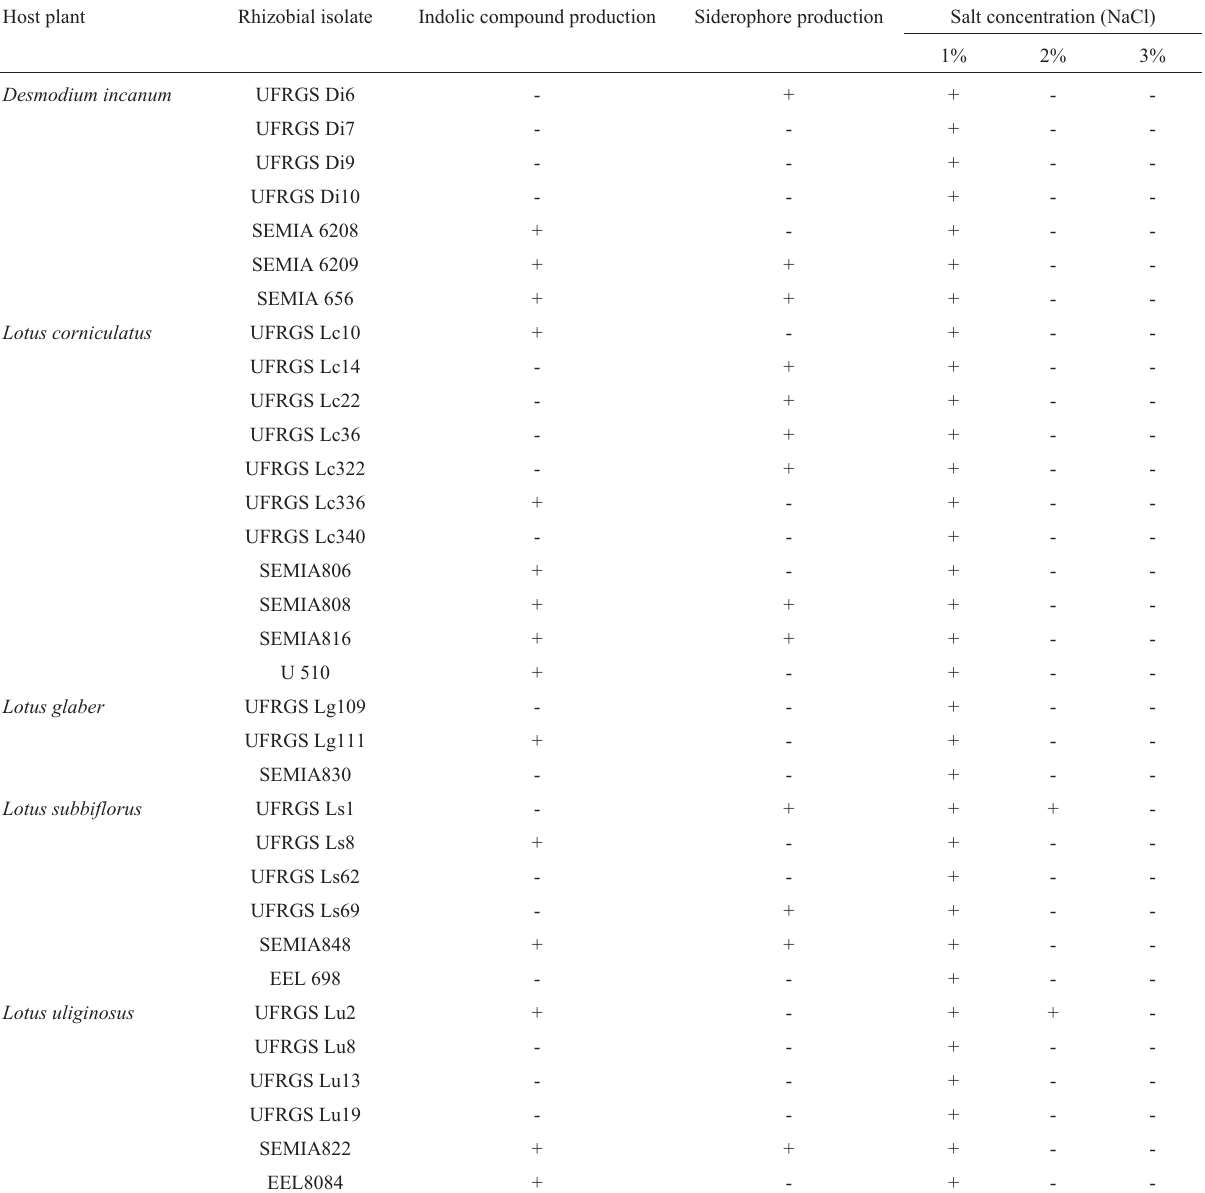
Table 1 - Native rhizobial isolates and reference strains. Their host plants and an evaluation of indolic compound and siderophore production and resis- tance to high salt concentrations are displayed. Host